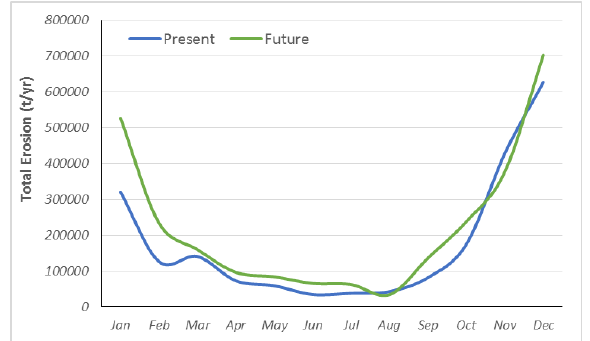
Figure 7. Monthly changes in estimated total erosion under